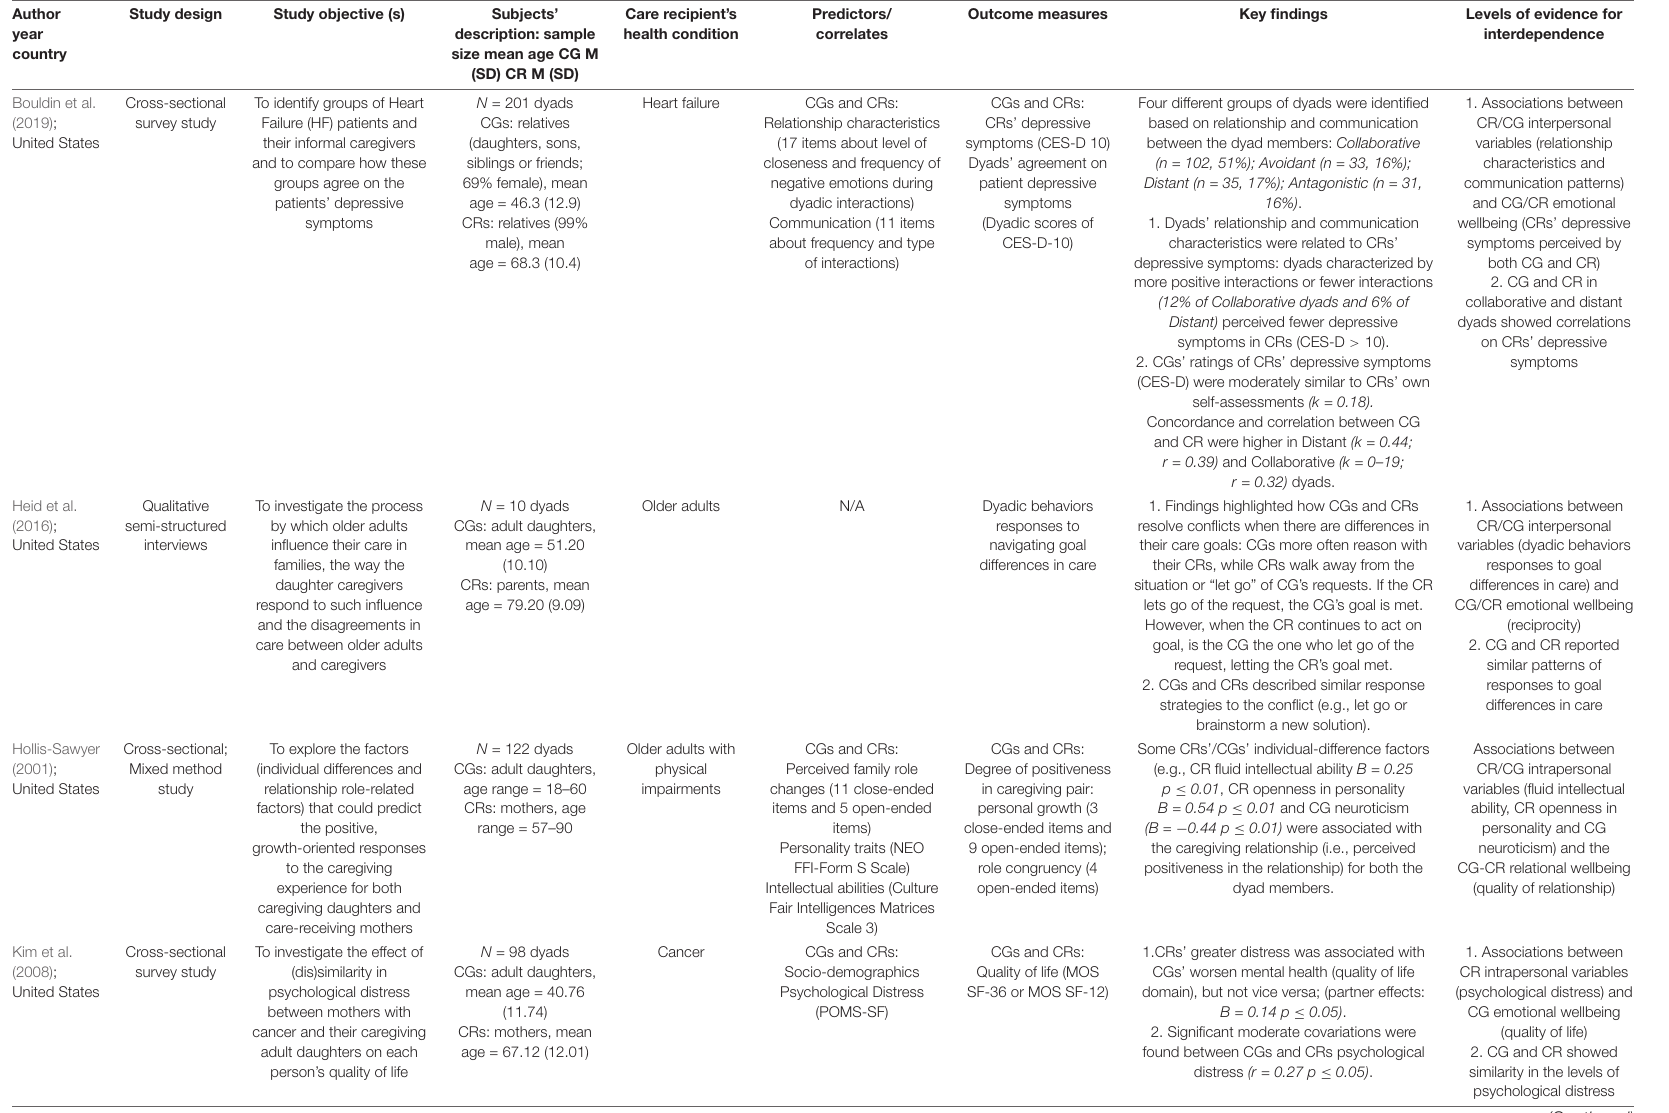
TABLE 1 | Characteristics of included